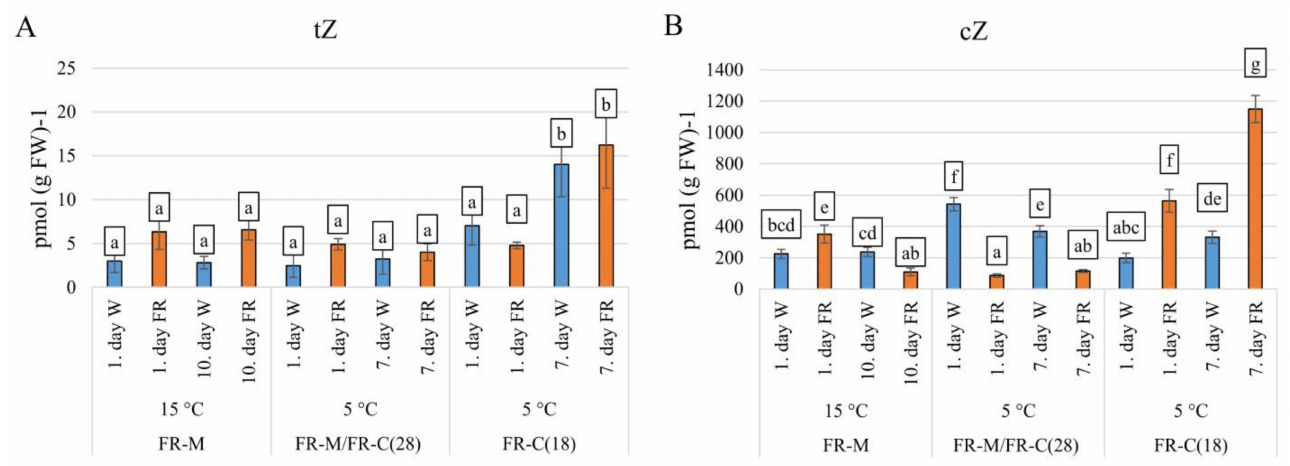
Figure 4. The impact of FR enrichment and moderate or low temperature on active cytokinin concentrations. ( A ): tZ, trans -zeatin; ( B ): cZ, cis -zeatin. Conditions are the same as in Figure